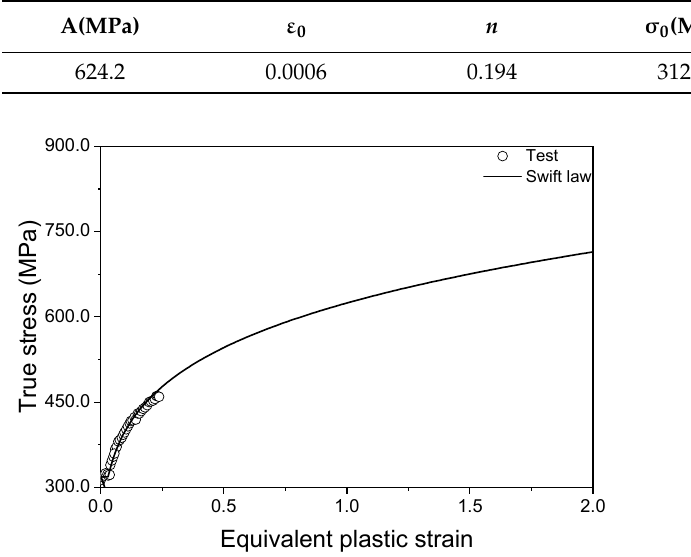
Figure 7. Flow stress beyond the onset of necking of JIS G3131 SPHC.